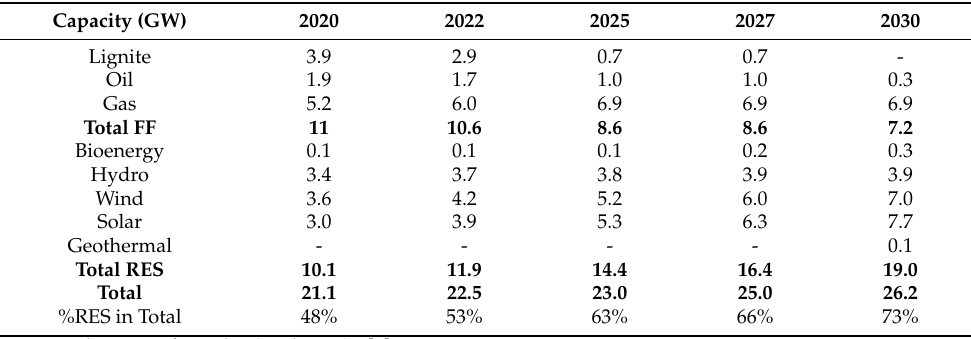
Table 2. Plans for energy generation capacity mix in Greece by type and GW of installed capacity for